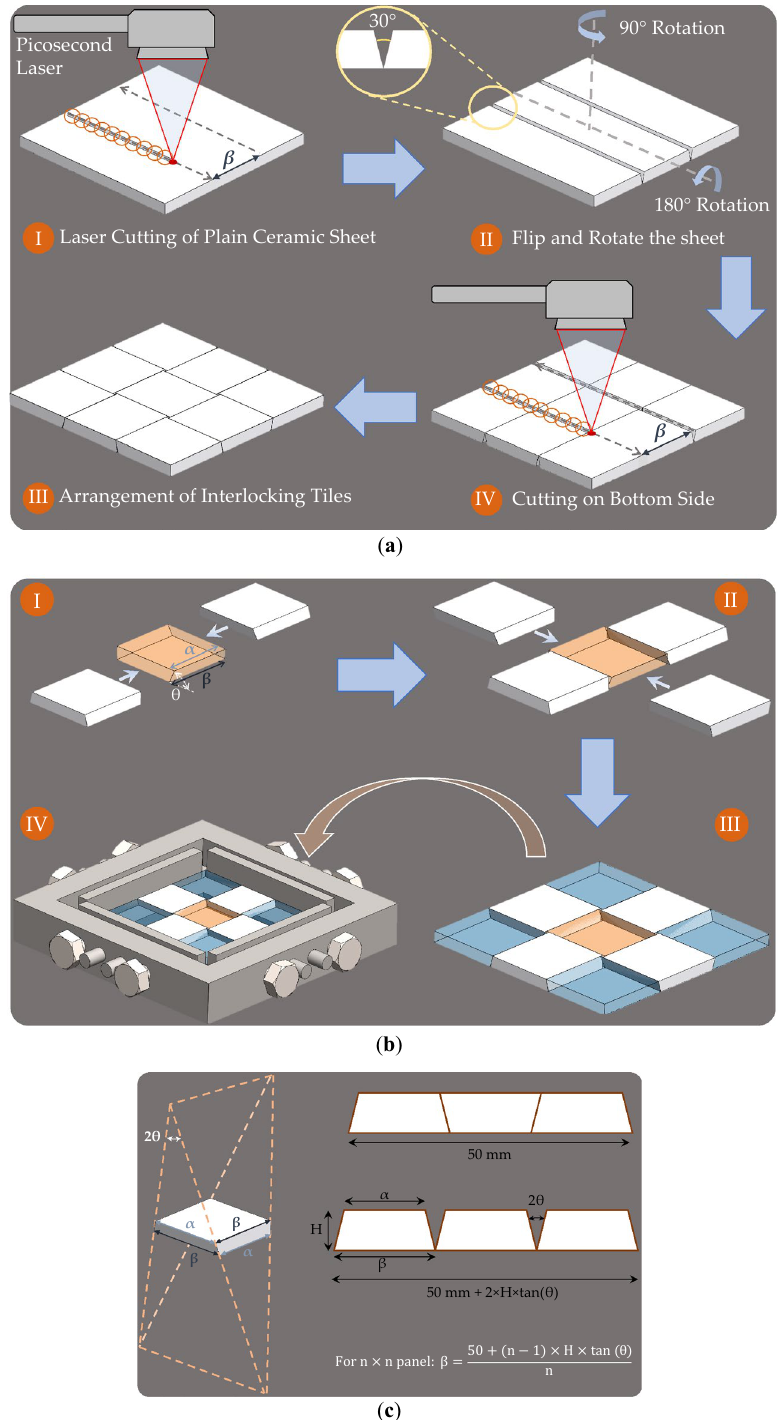
Figure 2. ( a ) Manufacturing of a 15° topologically interlocked ceramics using the laser material removal system. The circular pattern has been exaggerated for visualization; in reality, the diameter corresponds to the cut width. ( b ) Schematic of the assembly set-up for an architectured panel and the fixture. The four profiles with the power screws at the sides of the structure were used to impose an in-plane fixed confinement required for interlocking, and ( c ) line spacing to achieve a 50 × 50 mm 2 interlocking